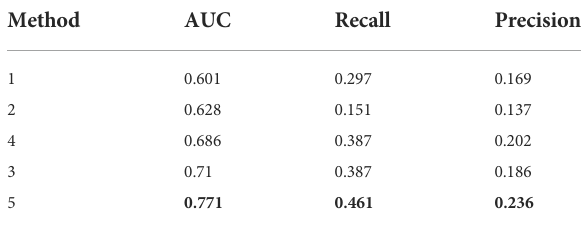
TABLE 4 Evaluation of methods used in classifying TLM and non TLM genes. Rows are sorted in ascending order by AUC performance. The highest scores in each metric are marked in